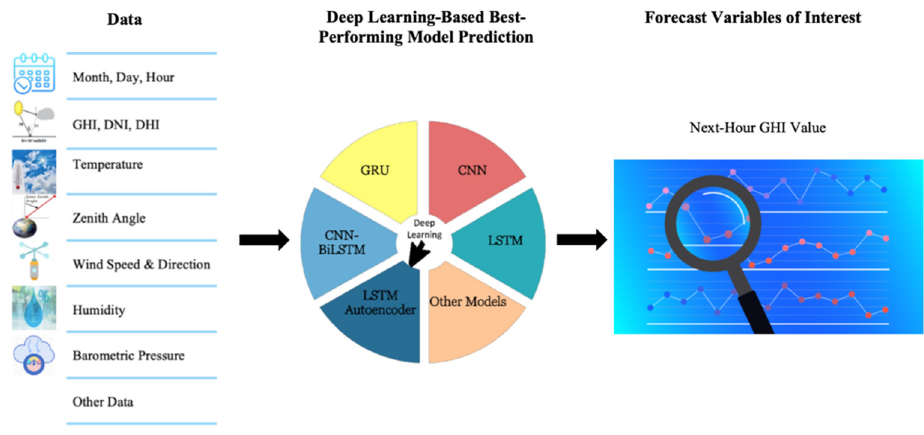
Figure 2. SENERGY: A high-level overview.